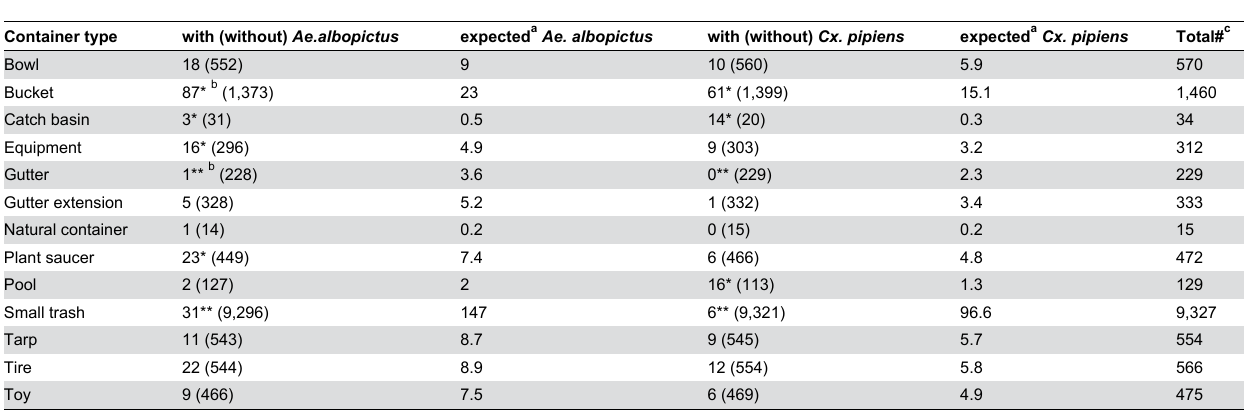
Table 4. Detailed presence data for Ae . albopictus and Cx. pipiens .